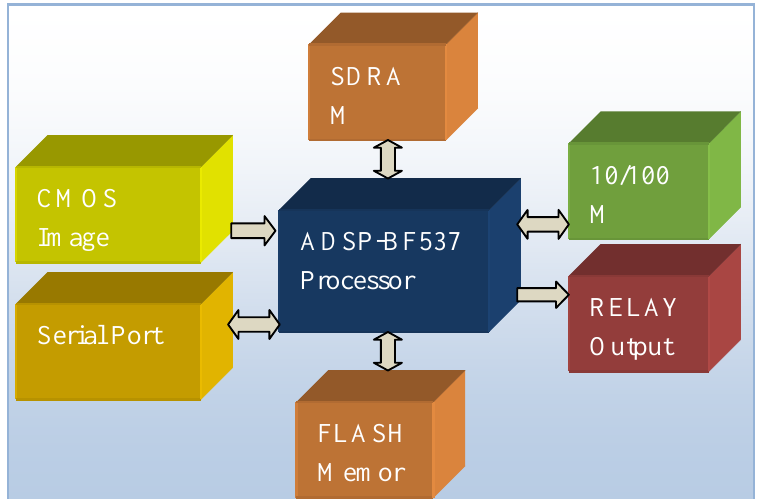
Figure 3. Hardware diagram of smart visual